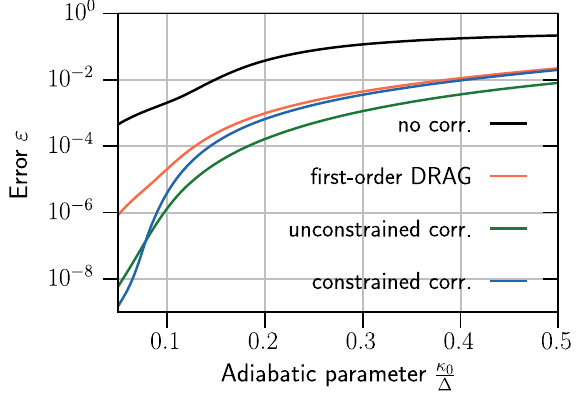
FIG. 5. Fidelity error in the implementation of a Hadamard gate in a superconducting qubit having an extra leakage level, cf. Eq. (53). We plot the error in the state-averaged infidelity as a function of the adiabatic parameter κ 0 = Δ . We choose ffiffiffi ffiffiffi p p λ ¼ 2 3 = κ π t = ð 4 κ 0 Þ . Curves corre- , − t 0 , and t 0 ¼ i ¼ f ¼ spond to different choices of corrections: Uncorrected Gaussian control pulse (black), first-order DRAG-corrected control as given in Eq. (9) of Ref. [4] (orange), unconstrained Magnus- based control sequence [see Eqs. (59) and (60)] (green), and constrained Magnus-based control sequence [see Eqs. (67) and (68)]